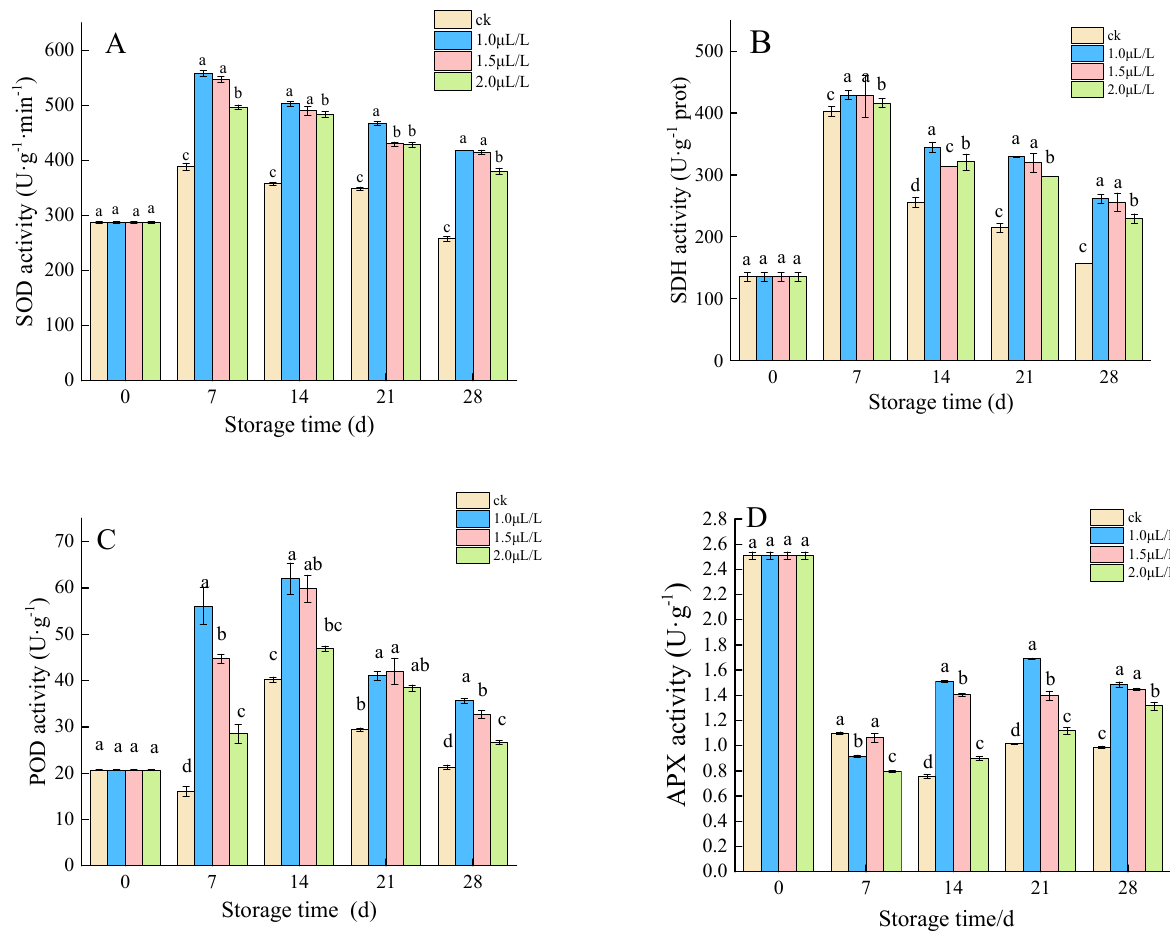
Figure 6. Effects of 1-MCP on SOD activity ( A ), SDH activity ( B ), POD activity ( C ) and APX activity ( D ). Different letters at each time point indicated a significant difference between treatments ( p < 0.05) by Duncan’s multiple range test.